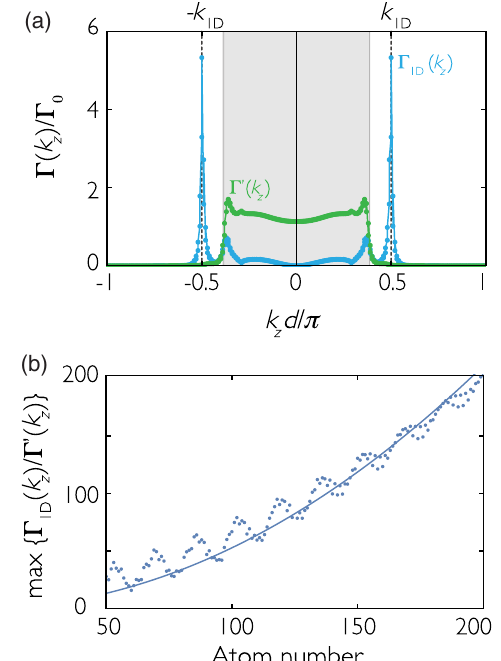
FIG. 15. Selectively radiant states of the s branch. (a) Guided k [ Γ 1 , light blue] and nonguided [ Γ 0 ð k , green] decay rates of z Þ z Þ D ð H 0 þ H the single-excitation eigenstates of H 1 versus the c D þ dominant wave vector k of each eigenstate, for a chain of z N ¼ 200 atoms coupled to the fiber. The control field Rabi 4 Γ frequency is Ω 0 , and the plot is restricted to eigenstates c ¼ that consist mostly of population in the s states (the s branch). The gray shaded area represents the region within the light line, the dashed lines show the guided-mode wave vector (cid:5) k 1 , and D the color lines are guides to the eye. (b) Scaling of the ratio Γ Γ 0 ð k with the number of atoms, at the wave vector k , 1 D ð k z Þ = z Þ z where it is maximum. The dots are numerical results, and the ≃ k = Γ 0 ð k curve represents the best quadratic fit, max f Γ 1 z Þ z Þg D ð 0 . 0053 N 2